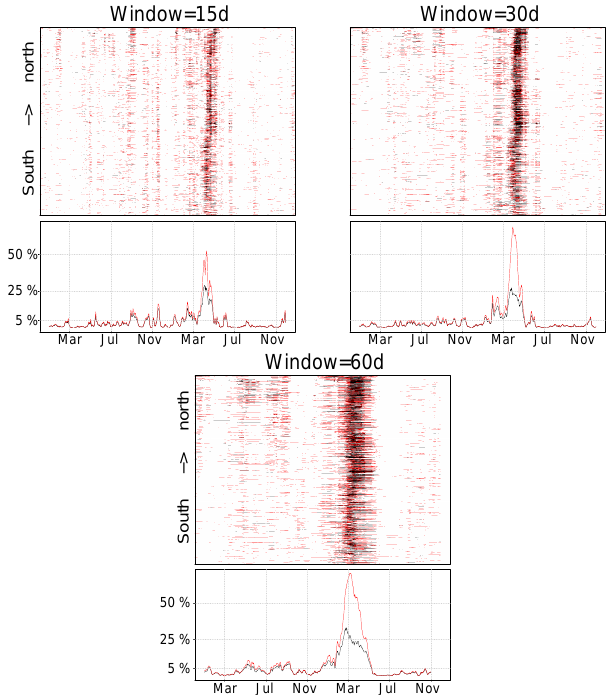
Figure 4. Latitudinal distribution (top panels) and total fraction (bottom panels) of stations with significant coincidence rates (red: α = 0 . 05; black: α = 0 . 01) between very early lilac flowering and extremely high window-mean temperatures for three different win- dow sizes. The x axes refer to the starting date of a window. The dashed horizontal lines at 5 % in the lower panels highlight the em- ployed group-significance